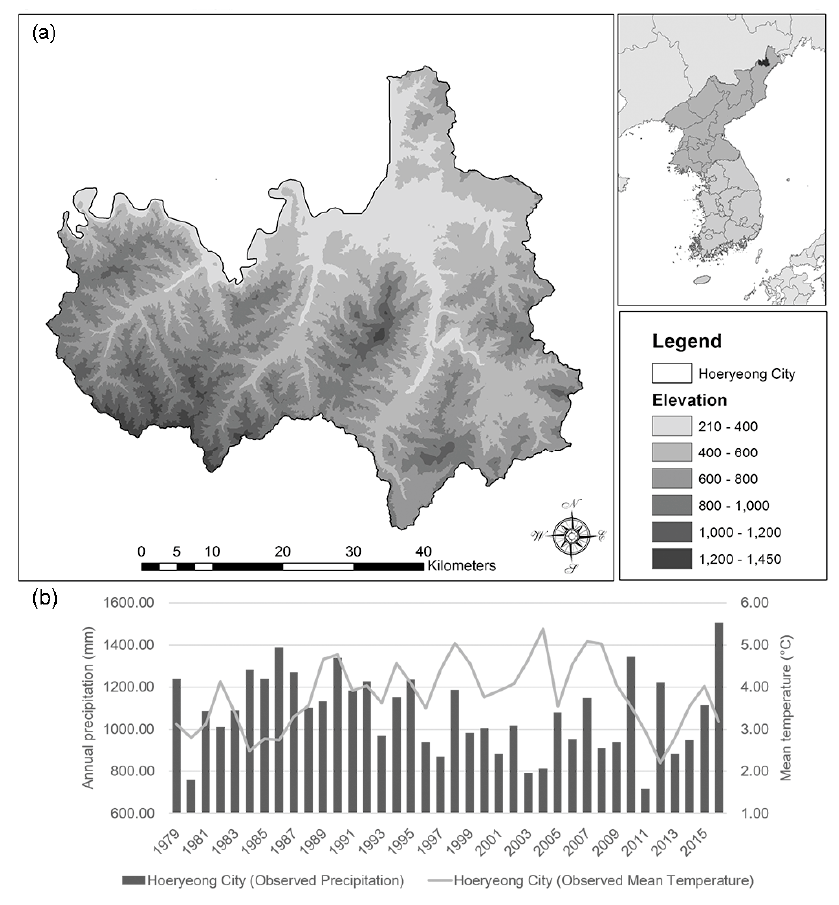
Figure 1. Elevation map and annual precipitation and annual mean temperature in the study area. ( a )